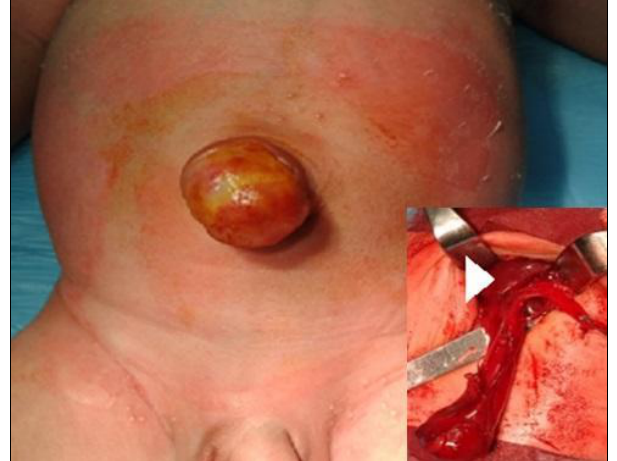
Figure 1: Hernia of the umbilical cord. The inset shows a freely floating gallbladder arising from under the surface of the liver